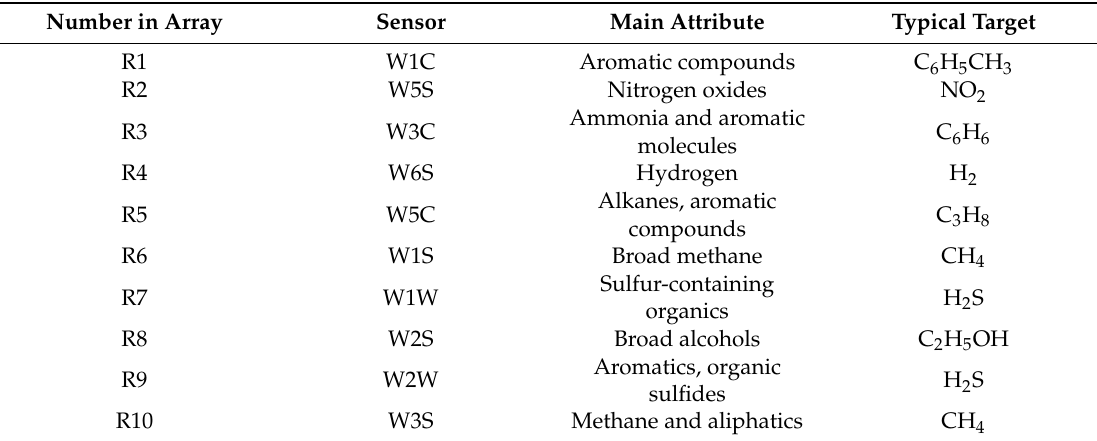
Table 1. Response features of the gas sensor